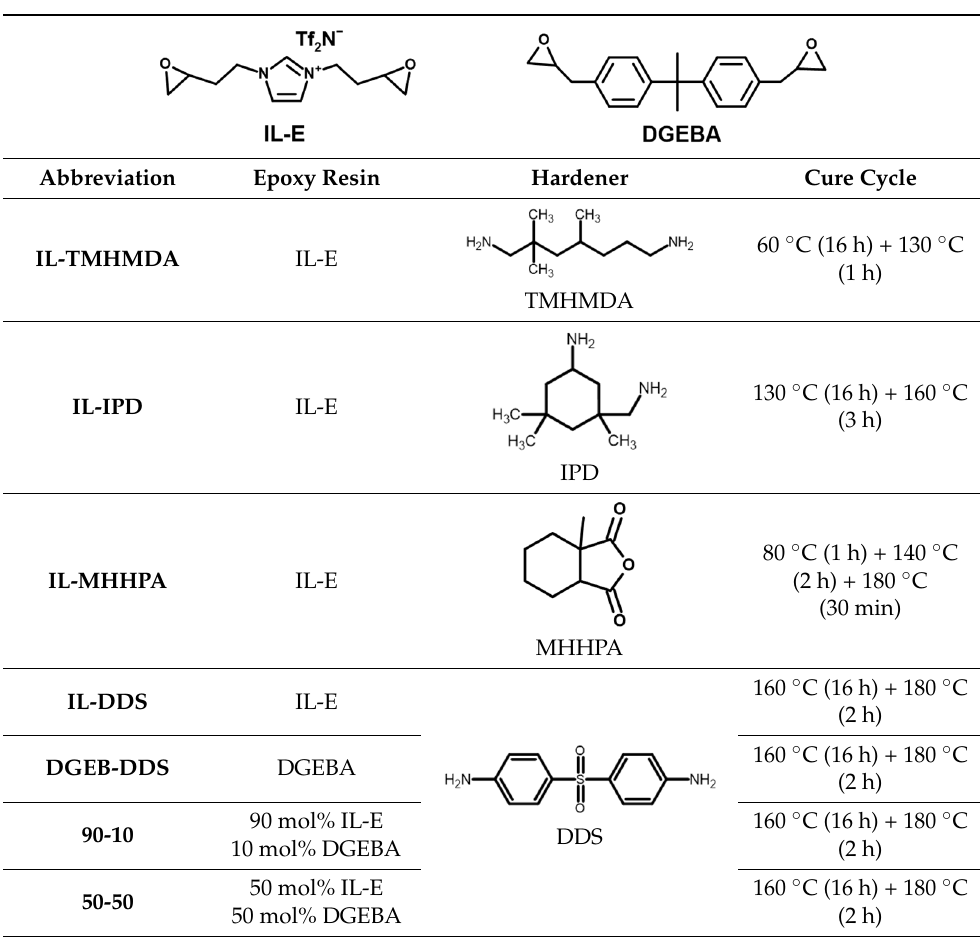
Table 2. Overview of the composition of the prepared epoxy ‐ based resins and their respective cure cycles.